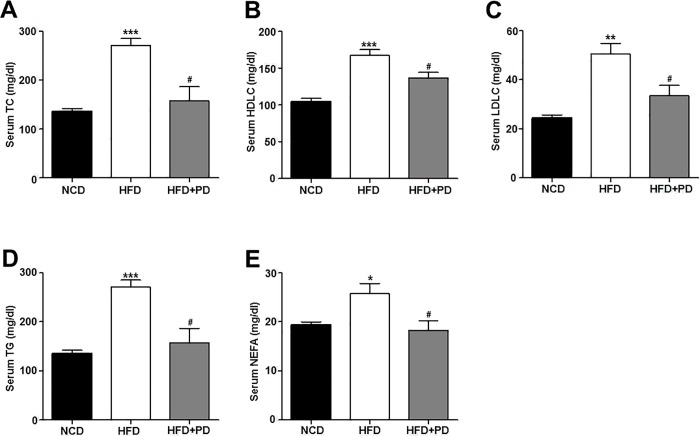
Effects of EGFR inhibition on serum lipid levels in HFD-fed mice.Serum concentrations were measured after 12 weeks of NCD, HFD, and HFD+PD treamtment. (A) Serum total cholesterol (TC) concentration (mg/dL). (B) HDL cholesterol concentration (mg/dL). (C) LDL cholesterol concentration (mg/dL). (D) Triglyceride (TG) concentration (mg/dL). (E) Non-esterified fatty acid (NEFA) levels (mg/dL). NCD, NCD-fed mice (NCD, black bars); HFD, untreated HFD-fed mice (white bars); HFD+PD, HFD-fed mice treated with PD153035 (gray bars). Data are expressed as the mean ± SEM. * P < 0.05, ** P < 0.001, *** P < 0.0001 NCD vs. HFD group. # P < 0.05, ## P < 0.001, ### P < 0.0001 HFD vs. HFD+PD group.